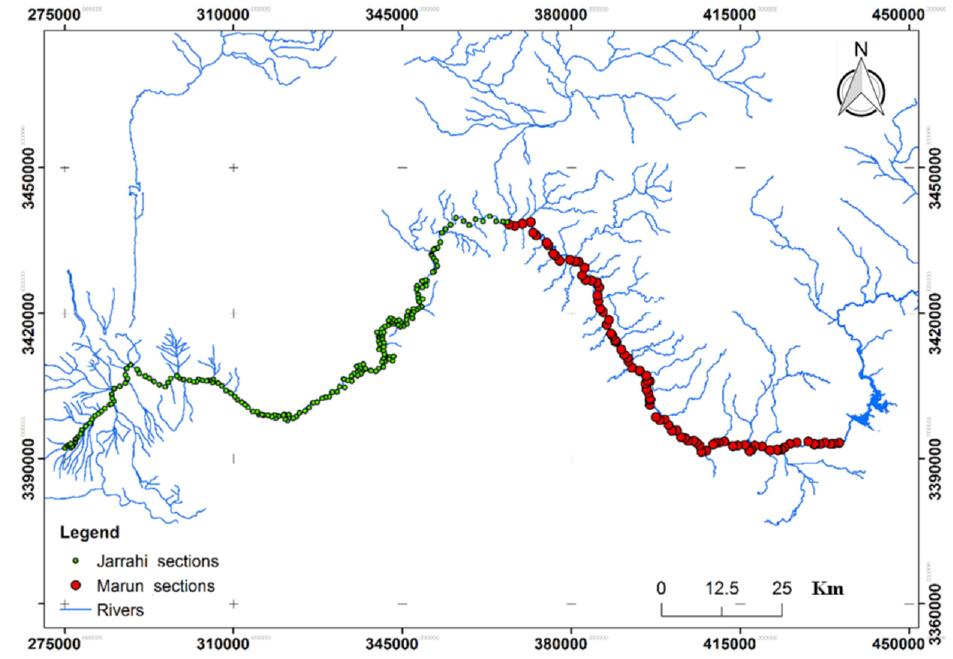
Figure 5. Location of 281 river sections in the Maroon and Jarahi study area.